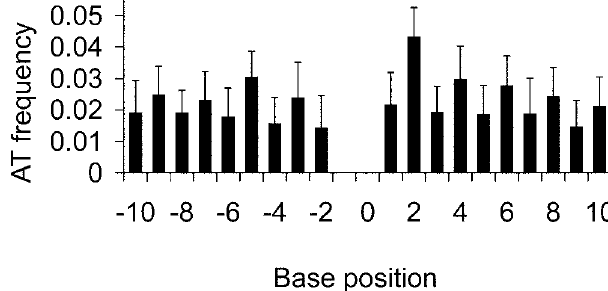
Figure 7. Location of Single AT Dinucleotide Motifs Relative to the Central AC Microsatellite in Flanking Sequences Lacking (AT) 2 þ Micro- satellites Figure shows frequency of AT dinucleotides around all length classes of AC repeat microsatellites longer than (AC) 2 (5 9 number of sequences, n = 2,924; 3 9 number of sequences, n = 3,309), with significantly greater numbers at odd positions 5 9 and even positions 3 9 . Data are for cassette T/A only. Error bars show upper 95% confidence limit. DOI: